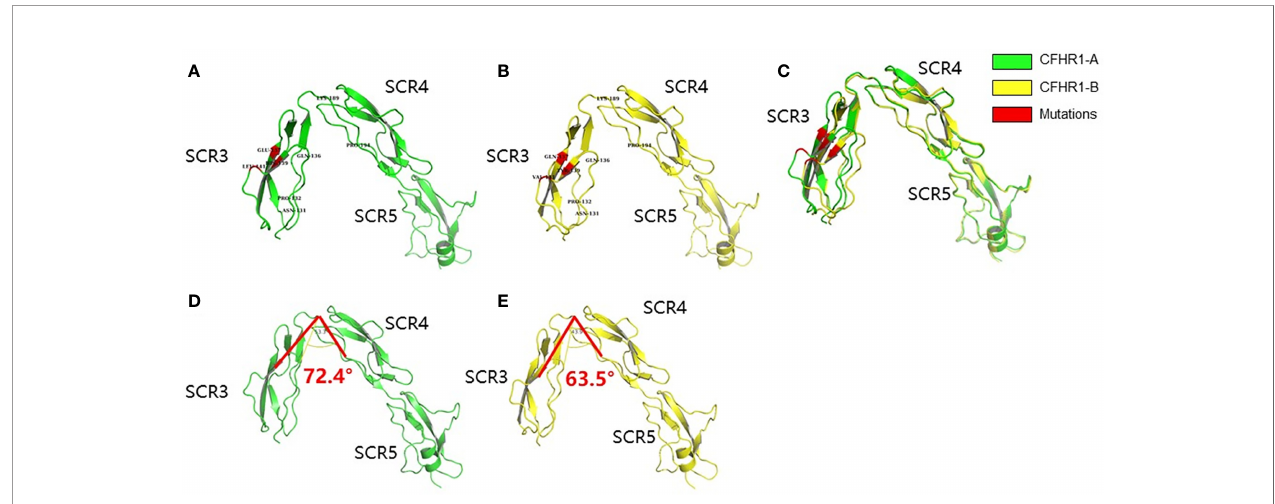
FIGURE 1 | Schematic diagram of the homologous modeling structure of FHR1*A and FHR1*B. The SCR3-SCR5 of FHR1*A (A) and FHR1*B (B) are shown in green and yellow, respectively. The mutant amino acids are shown in red. The aligned view of SCR3-SCR5 of FHR1*A and FHR1*B showed some differences (C) . The structures of SCR4-SCR5 are identical between FHR1*A and FHR1*B, while SCR3 of FHR1*B is more prone to SCR4-5 than that of FHR1*A. The representative angle ( ∠ p.139-p.189-p.194) of CFHR1 *B (E) is smaller than that of CFHR1 *A (D) , with a maximum angle difference of 8.9°.